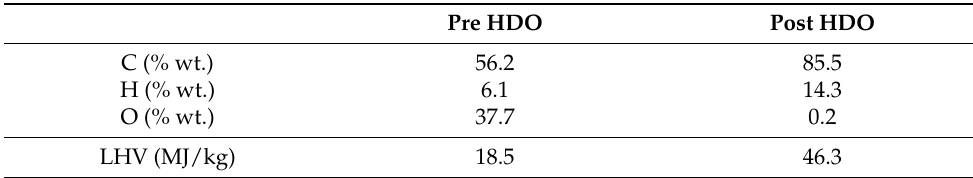
Table 5. Oil characteristics before and after